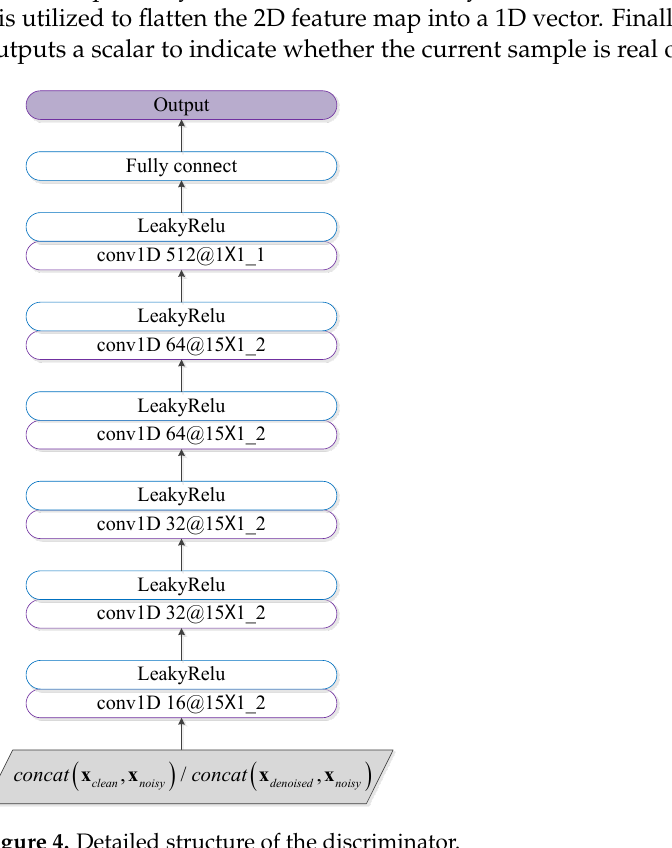
Figure 4. Detailed structure of the discriminator.